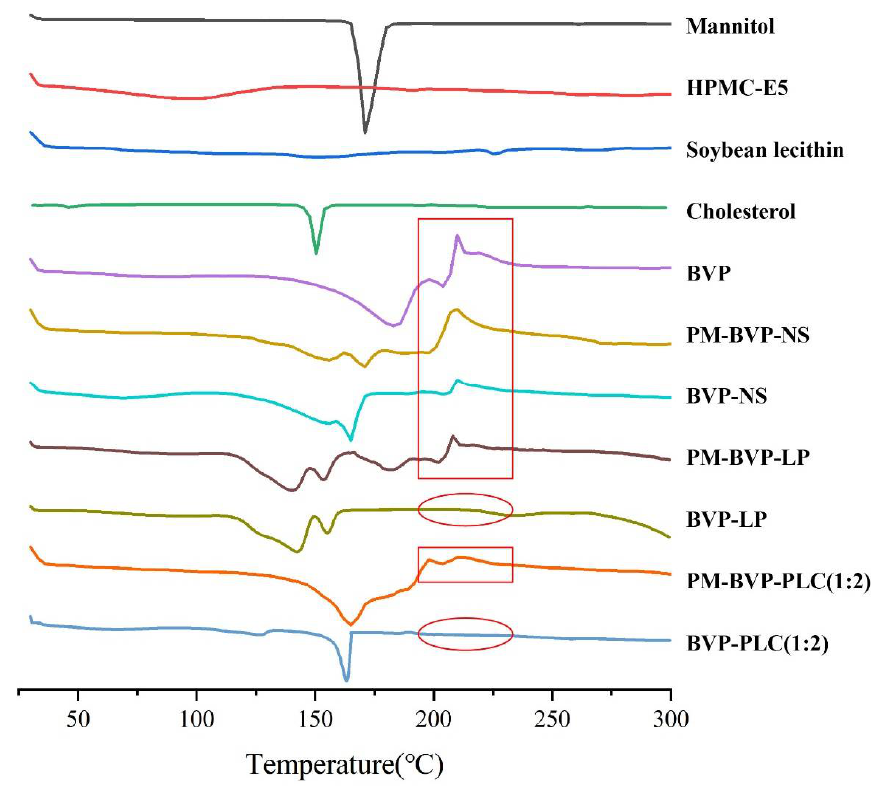
Figure 7. Differential scanning calorimetry (DSC) thermograms of mannitol, HPMC-E5, soybean lecithin, cholesterol, BVP, PM-BVP-NS, BVP-NS, PM-BVP-LP, BVP-LP, PM-BVP-PLC (1:2) and BVP-PLC (1:2).